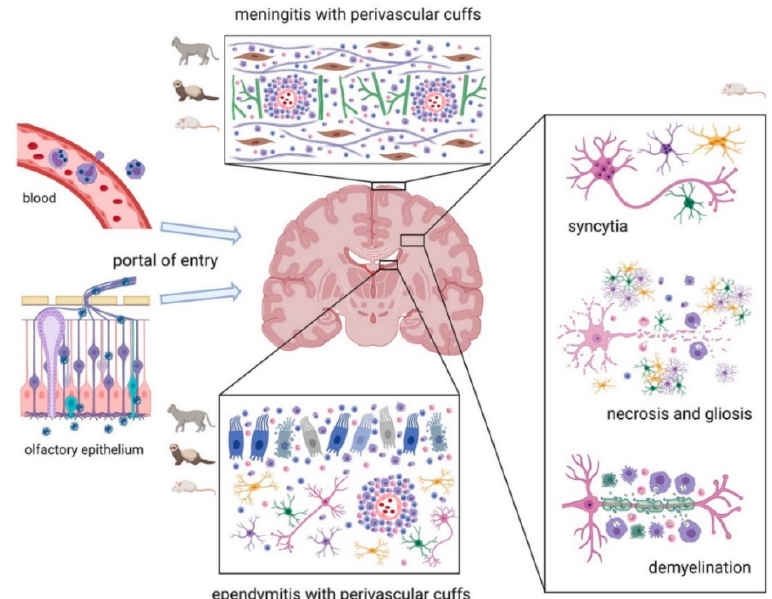
been created with